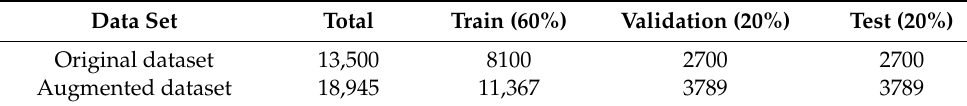
Table 1. Description of number of raw dataset and augumented dataset.